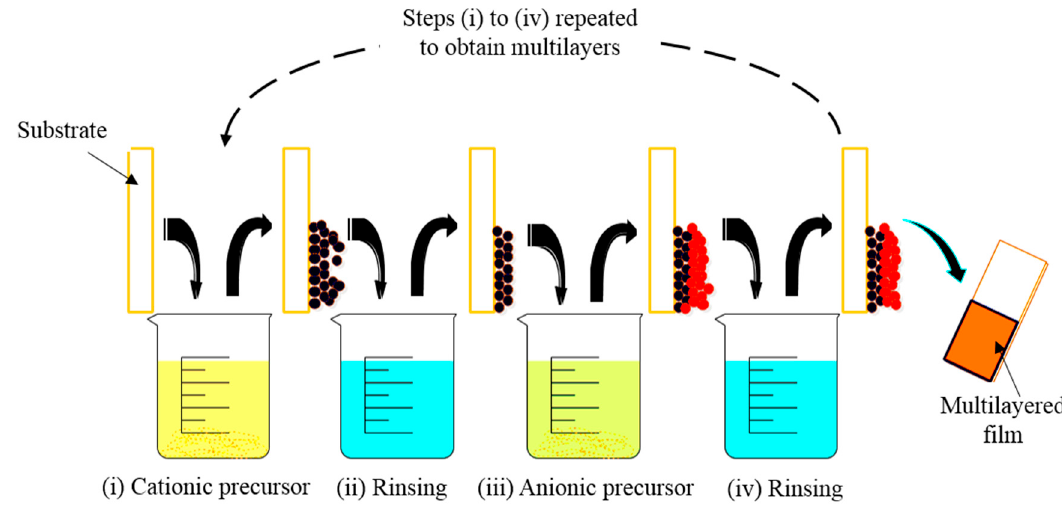
Figure 13. Schematic illustration of successive ionic layer adsorption and reaction (SILAR) method.